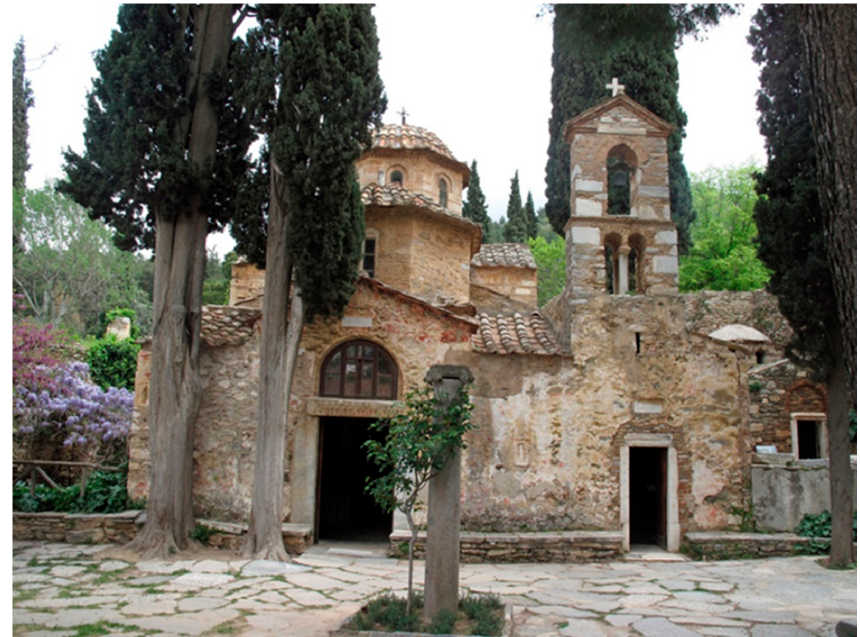
Figure 5. Front façade of the Kaisariani monastery.